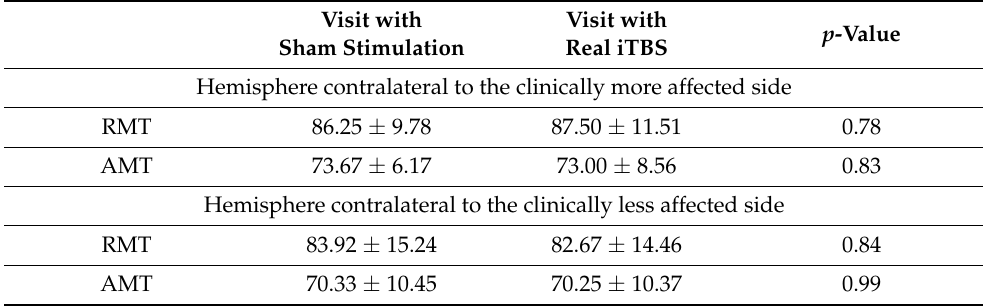
Table 2. Minimal stimulation intensities to elicit motor evoked potentials (MEP). Visit